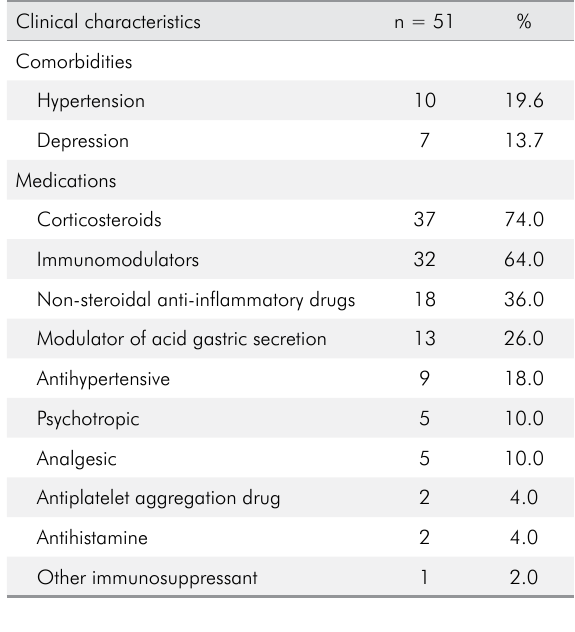
Table 1. Clinical characteristics of the 51 subjects with rheumatoid arthritis in the